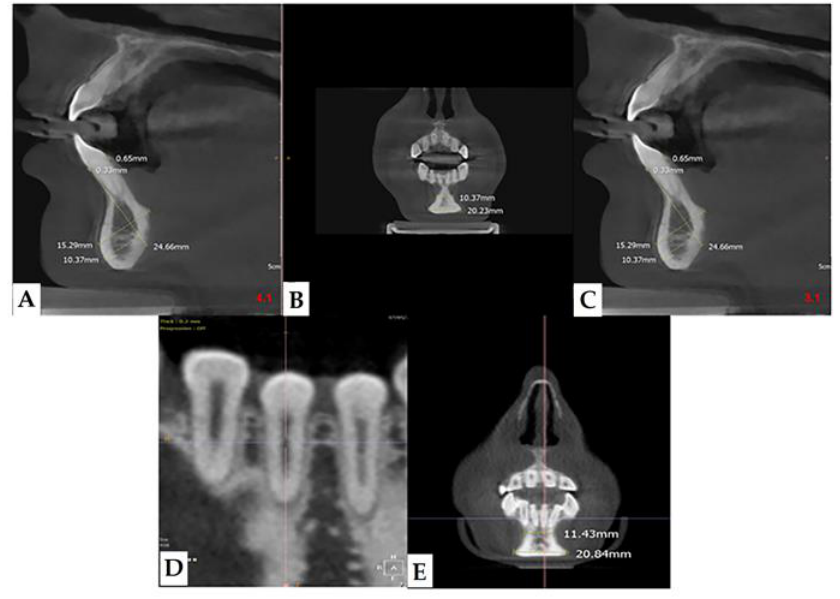
Figure 7. CBCT images showing bone resorption in the mandible anterior region in a patient with mild OI ( A ), sagittal 4.1, ( B ) coronal, ( C ) sagittal 3.1, ( D ), and ( E ) particular.